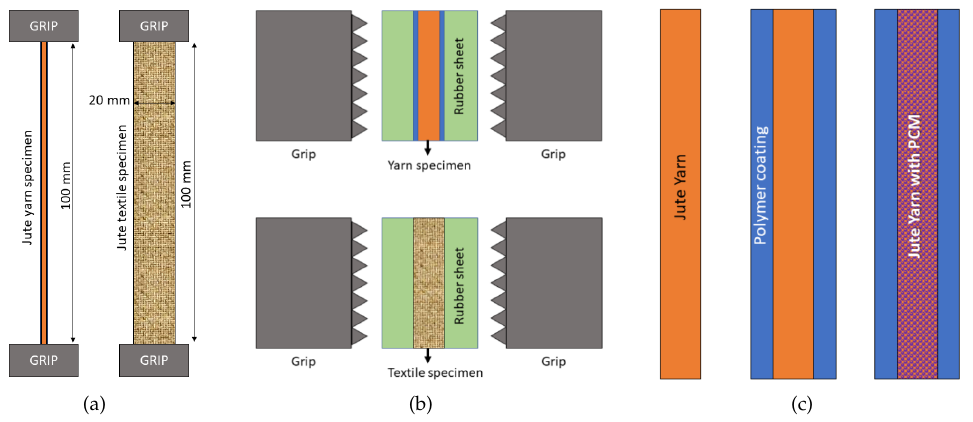
Figure 3. Samples preparation: ( a ) dimensions for the direct tensile tests, ( b ) details of rubber sheets glued at specimens’ ends to avoid slippage during testing, and ( c ) yarn